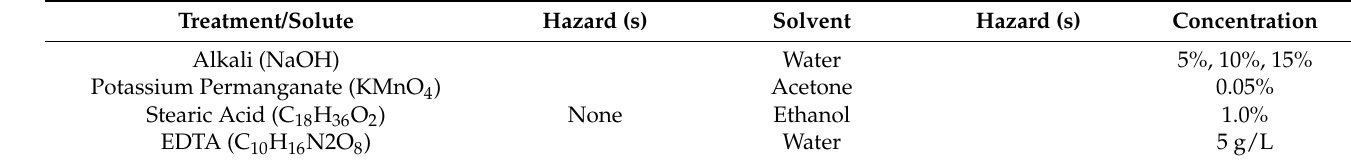
Table 1. Treatment solutions suggested by M. Sood and G. Dwivedi [14,22].